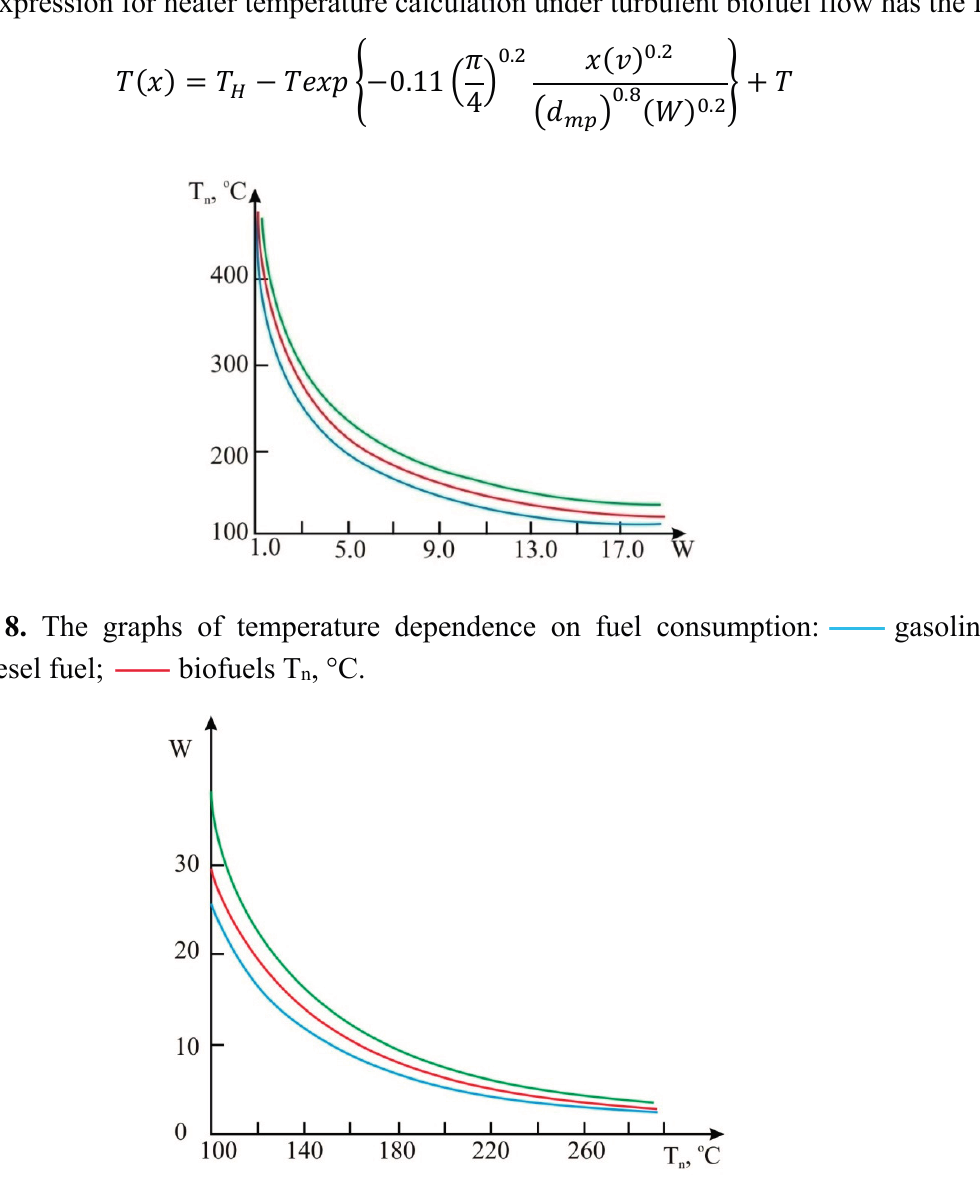
Figure 9. The graphs of fuel consumption dependence on heater temperature: gasoline; diesel fuel;